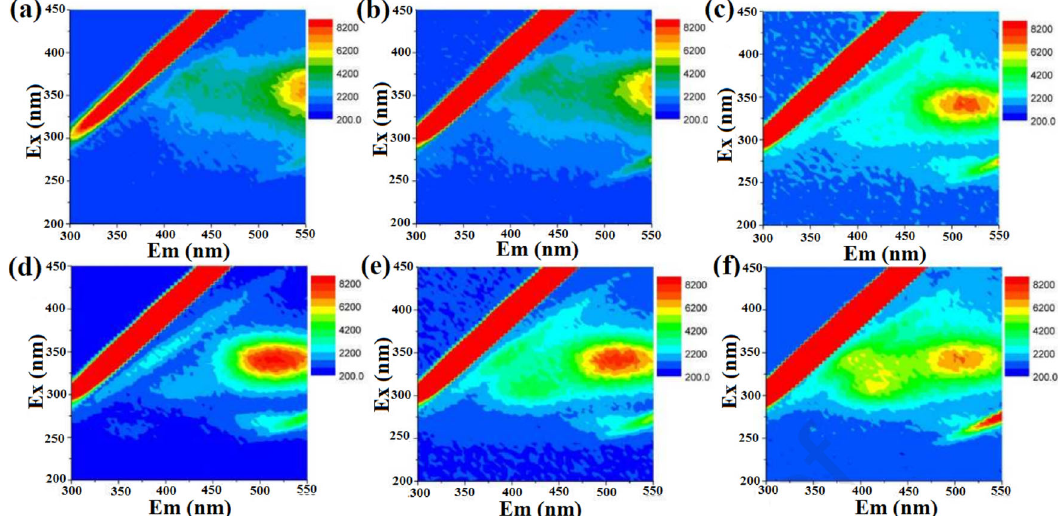
Fig. 5 Emission fl uorescence characteristics of LDHs. a – f The 3D-EEMs of the TC degradation by FeCo-LDH-1.5, adapted with permission from ref. 139 , Copyright, 2022,